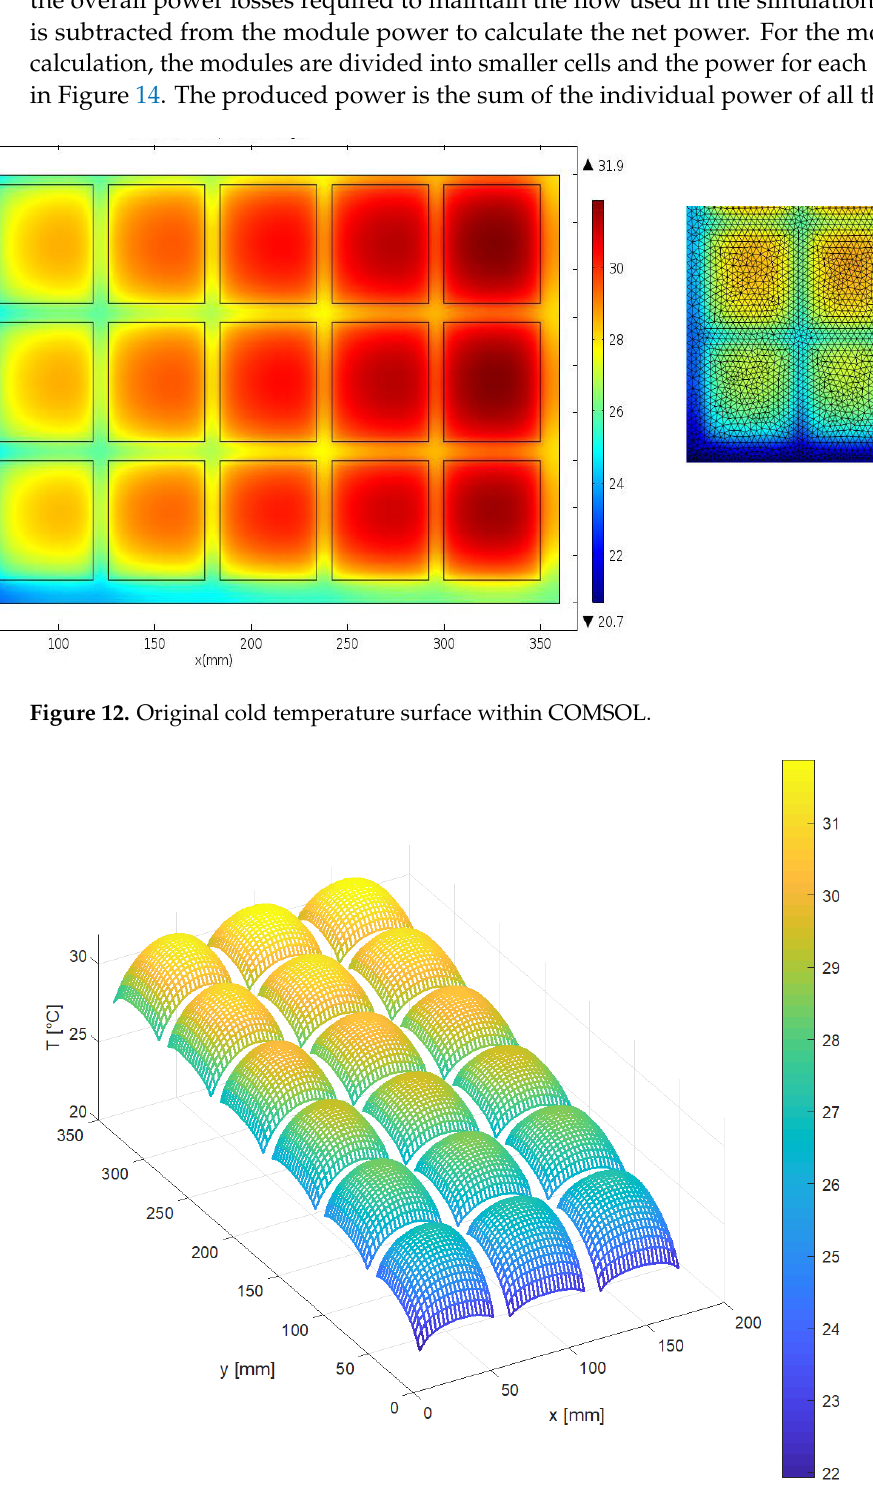
Figure 13. Cold side temperature profile after resampling.